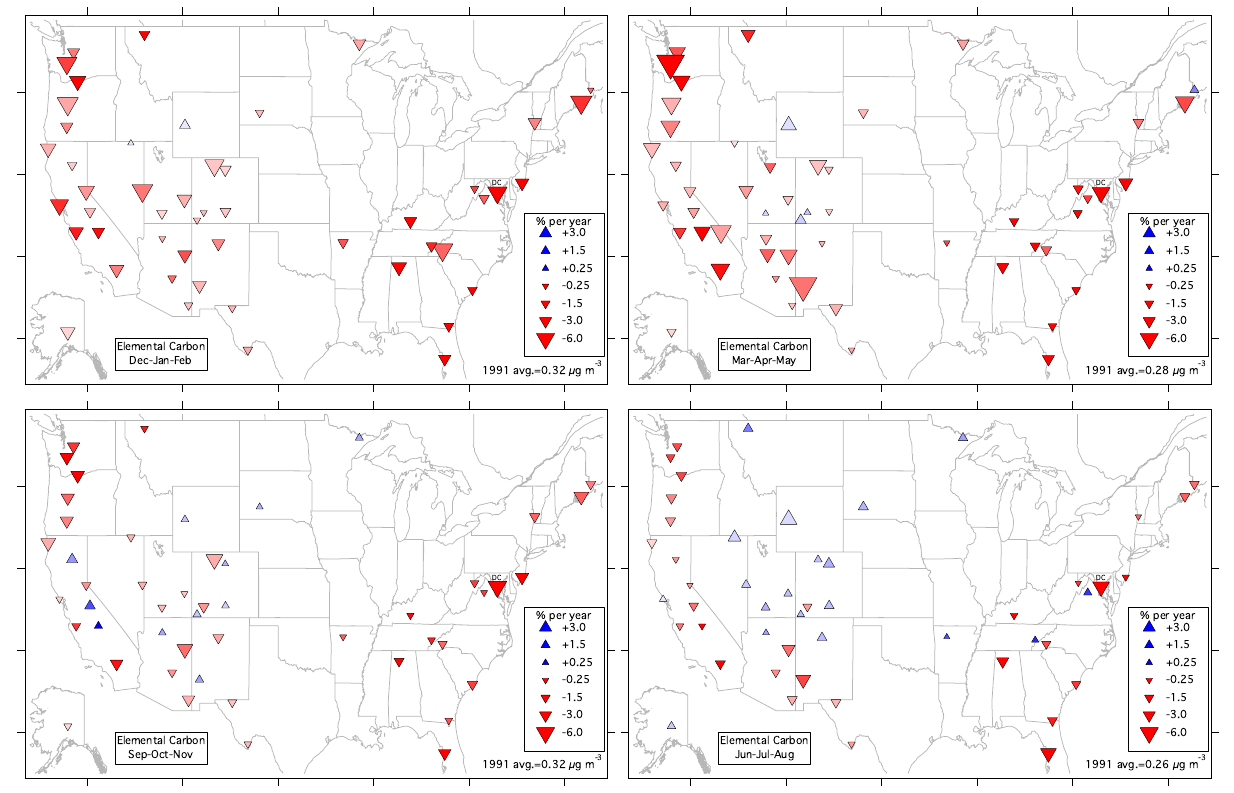
Fig. 3. Quarterly exponential trends in elemental carbon at IMPROVE network sites. As in Fig. 2, trends are for all stations with sufficient data between 1 March 1990, and 29 February 2004. Marker size indicates the magnitude of the trend. Triangle direction and blue or red color corresponds to the sign of the trend. Color saturation is proportional to the average concentration in 1991 with full saturation at twice the national median for each quarter. The only urban site in Washington DC is marked. Averages in the bottom right corners exclude Washington